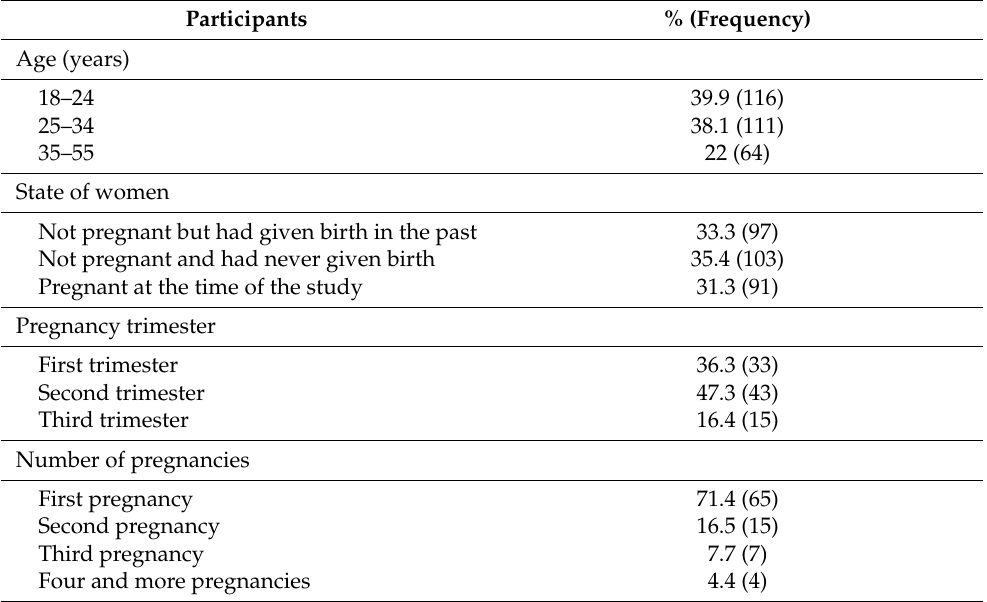
Table 1. Characteristics of the study participants.